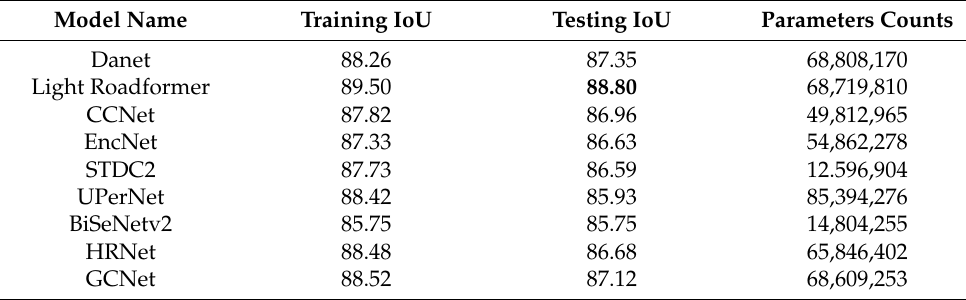
Figure 10. Comparison of the semantic segmentation model’s training process. Table 2. The performance of different network models on